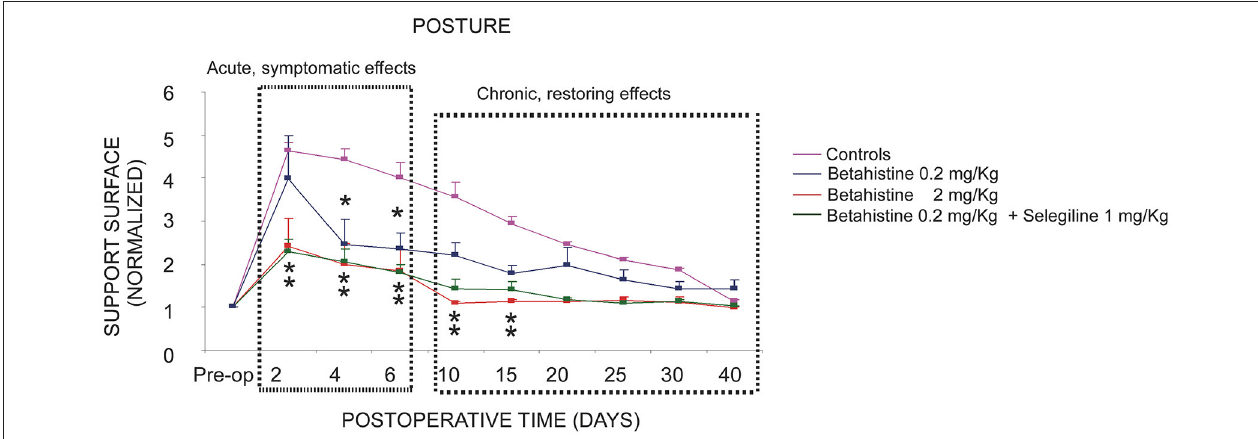
FIGURE 1 | Comparison of the effects of the three oral pharmacological treatments with respect to the controls on the compensation of the static postural deficits. Curves indicating the mean post-operative recovery of the support surface in the four experimental groups of cats: UVN untreated cats (controls, saline water), UVN cats receiving betahistine 0.2 mg/kg per os , UVN cats receiving betahistine 0.2 mg/kg plus selegiline 1 mg/kg per os, and the UVN group of cats receiving betahistine 2 mg/kg per os . Data recorded after vestibular deafferentation were related to individual references and normalized with respect to the pre-operative values referred to unity (one being close to 50 cm 2 ). Error bars represent S.E.M. Note the acute and chronic effects of high and low dose betahistine treatment in UVN cats. The normalized effects on posture recovery are roughly similar with the lower dose of betahistine (0.2 mg/kg), the lower dose co administrated with selegiline (1 mg/kg), and the higher dose (2 mg/kg) during this early time window (2–6 days). By contrast, only the higher dose and the co administration treatment induced a significant reduction of the recovery time of balance function during the chronic stage (10–30 days).